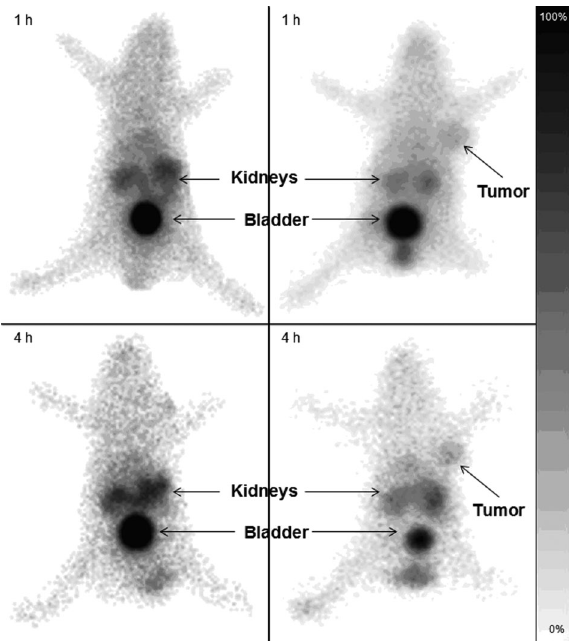
Figure 3. Scintigraphic images (256 (cid:3) 256 (cid:3) 16 matrix size) obtained at 1 and 4 h after 99m Tc-HYNIC- b Ala-Bombesin (7-14) intravenous injection (7.4 MBq) into healthy mice ( left ) and Capan-1 tumor-bearing mice ( right ) anesthetized with ketamine and xylazine. Arrows indicate tumor foci, kidneys and bladder.